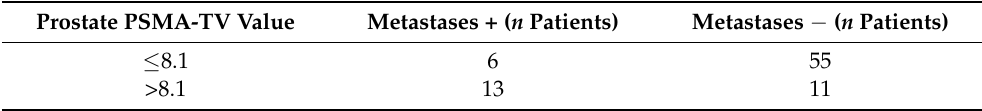
Table 4. Receiver Operating Characteristic (ROC) curve analysis.